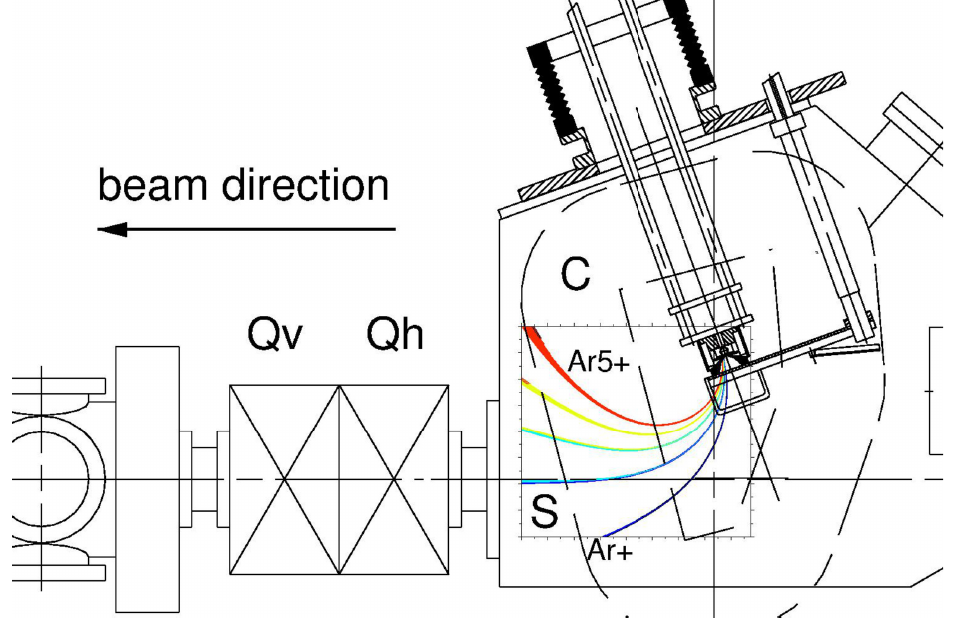
Figure 9. PIG ion source with radial ion beam extraction within the magnetic dipole field perpen- dicular to the drawing plane. Different charge states from Argon (Ar + to Ar 5 + ) will be extracted and deflected according to their m / q ratio. The beam transport through that magnetic dipole field produced by the coil C would not be possible without a high degree of SCC. Two magnetic quadrupoles behind the dipole focus the ion beam in horizontal direction Qh and in vertical direction Qv , respectively. Simulation area is marked with